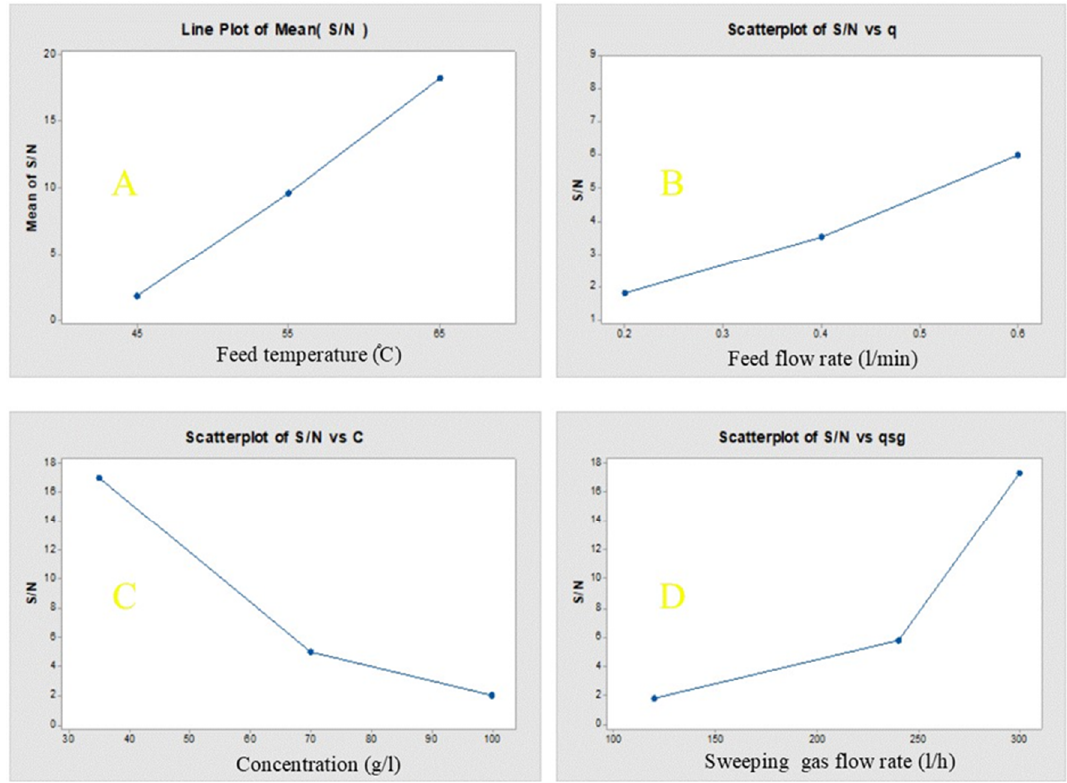
Figure 8. E ff ect of operating variables on S / N ratio: ( a ) Feed temperature; ( b ) Feed flow rate; Figure 8. Effect of operating variables on S/N ratio: ( a ) Feed temperature; ( b ) Feed flow rate; ( c ) ( c ) Concentration; ( d ) Sweeping gas flow Concentration; ( d ) Sweeping gas flow rate.